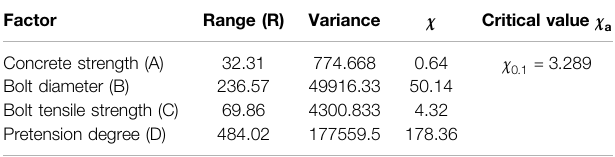
TABLE 4 | Results of range and variance analyses of initial shear stiffness.